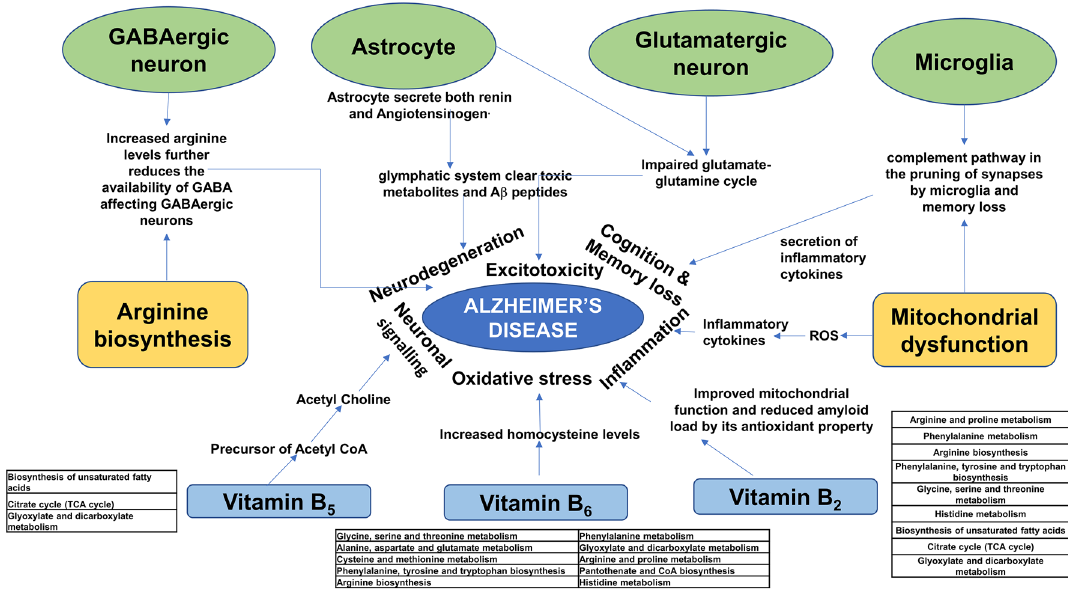
Figure 7. Summary of overall findings from multi-omics studies. Role of vitamin B 2 , B 5 and B 6 modulated pathways with overlap with deregulated metabolic pathways in AD and its implications for observed symptoms. Cell types affected and their role in symptoms associated with AD. Deregulated energy metabolism and their effect on AD symptoms. Figure generated using Microsoft power point 2019 MSO (Version 2212